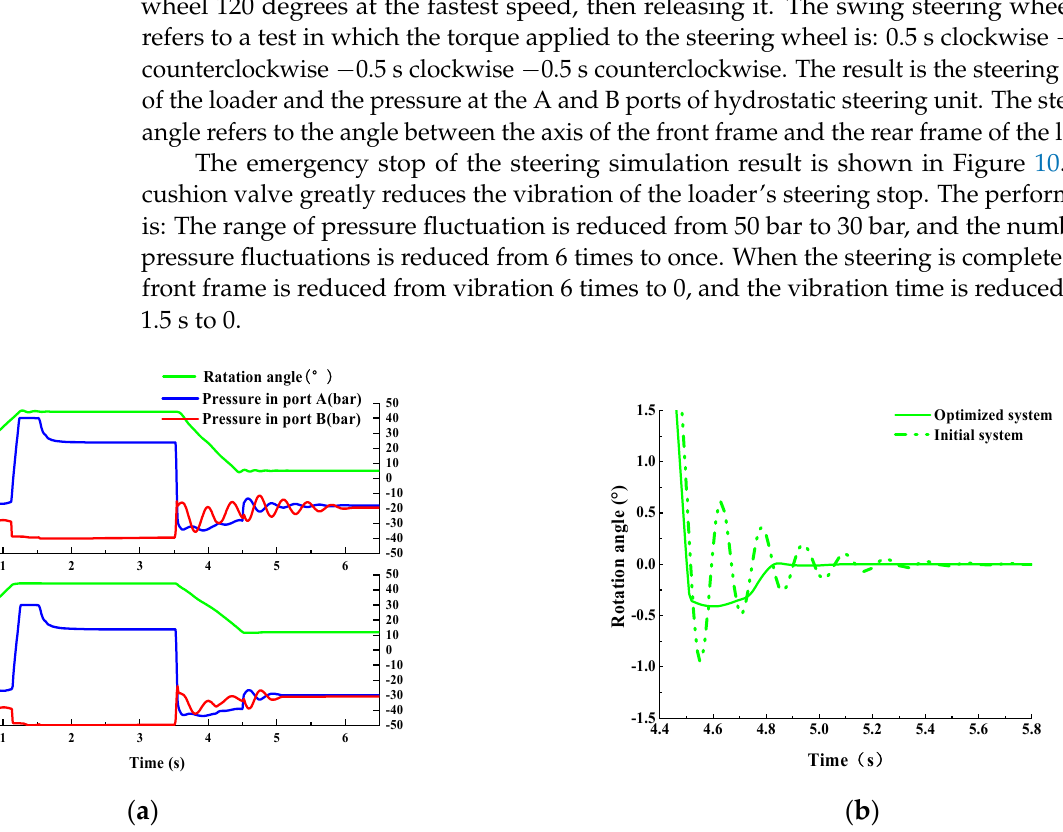
( b ) Figure 11. The swing steering wheel simulation result: ( a ) cylinder pressure and frame angle curve; ( b ) partial enlarged view of the steering angle. In summary, the comparative simulation test verifies that the cushion valve has a significant improvement effect on pressure start shock and pressure fluctuation. The cush- ion valve can be used to optimize the hydraulic steering system of the wheel loader. 6.2. Prototype Comparison Test In order to accurately analyze the impact of the cushion valve on the steering system of the loader and study the optimization function of the steering stop vibration, it was necessary to install the cushion valve on the steering system of the loader to conduct a prototype test. The test prototype is still the 5-ton loader used in the previous test, and the test site is a flat asphalt road. For the severity of vibration, on the one hand, the driver’s feeling is subjectively judged; on the other hand, it is objectively judged by data. Since the driver’s subjective feelings cannot be quantified, this article uses pressure and acceleration to evaluate the steering effect. Therefore, pressure sensors are installed on the A and B